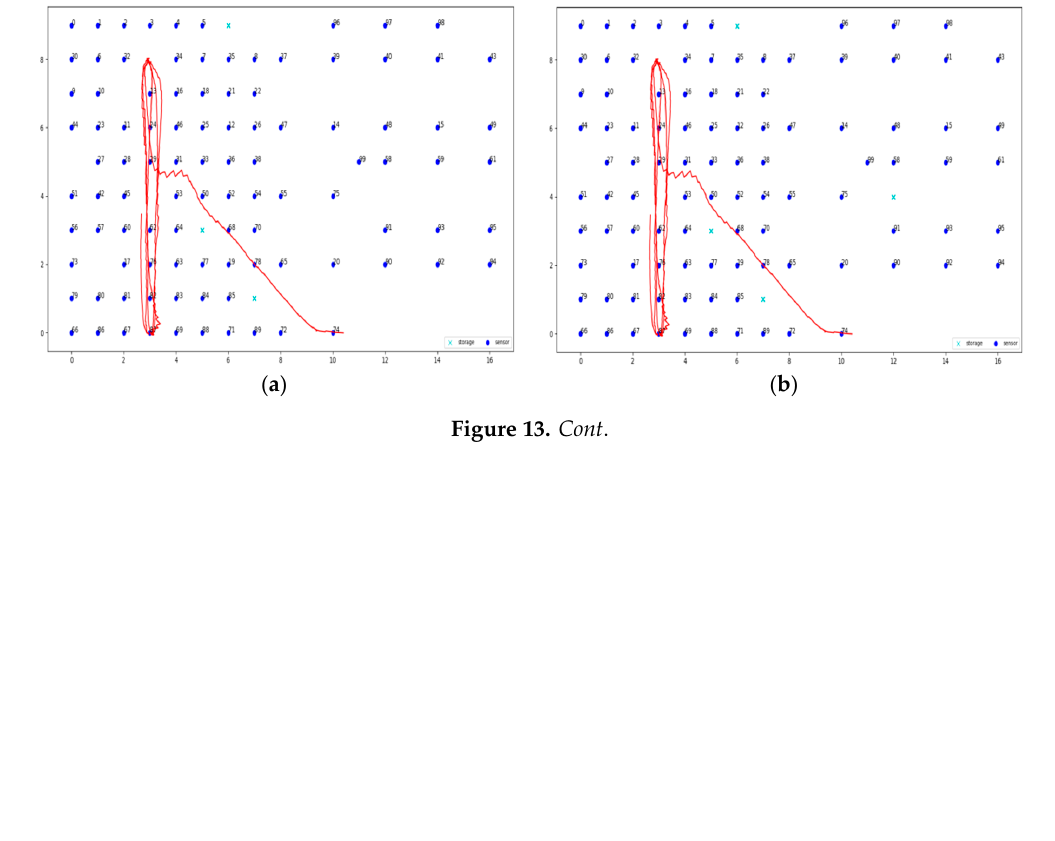
Table 2. Average privacy achieved by the DCA for the topology of 37 nodes.